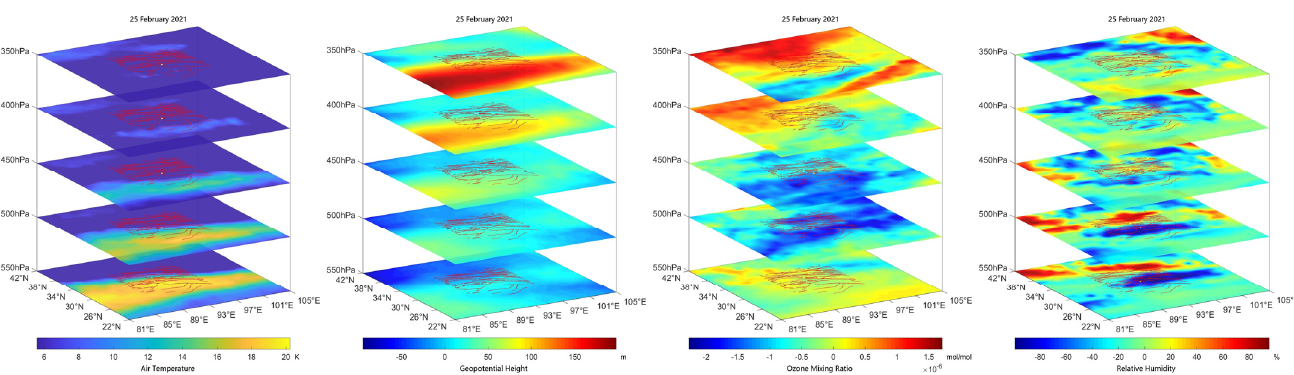
Figure 4. Composite atmospheric anomaly map associated with earthquake in Biru on 25 February. The epicenter and faults are shown by yellow point and red lines, respectively. For each row, the subplots represent air temperature, geopotential height, ozone mixing ratio and relative humidity from left to right.